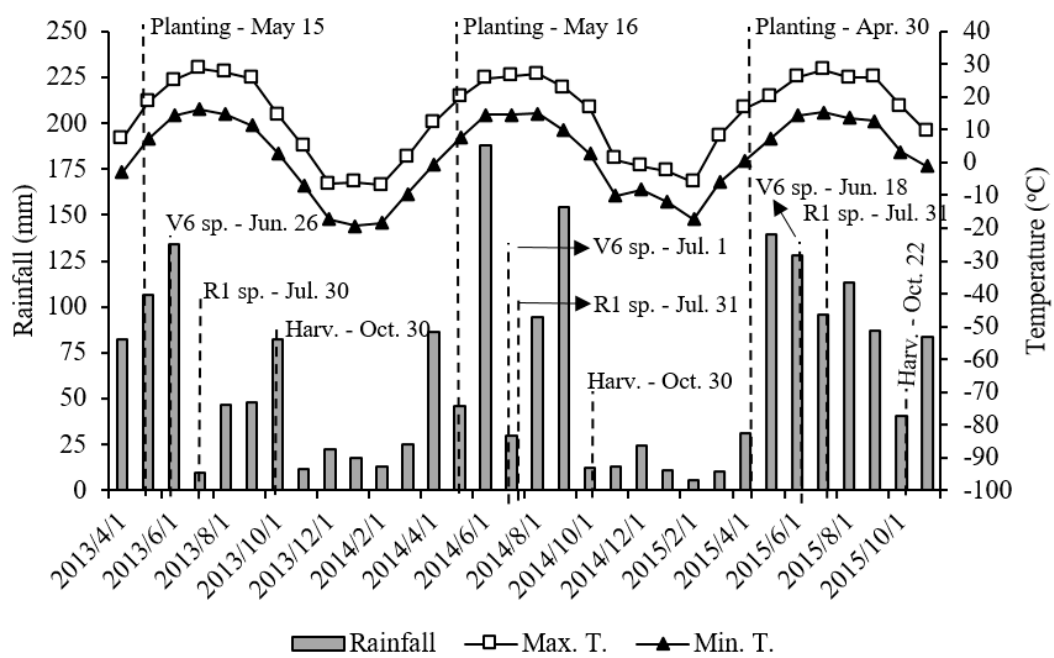
Figure 1. Rainfall, maximum, and minimum temperatures obtained from the weather station located in Lamberton, MN in 2013–2015.